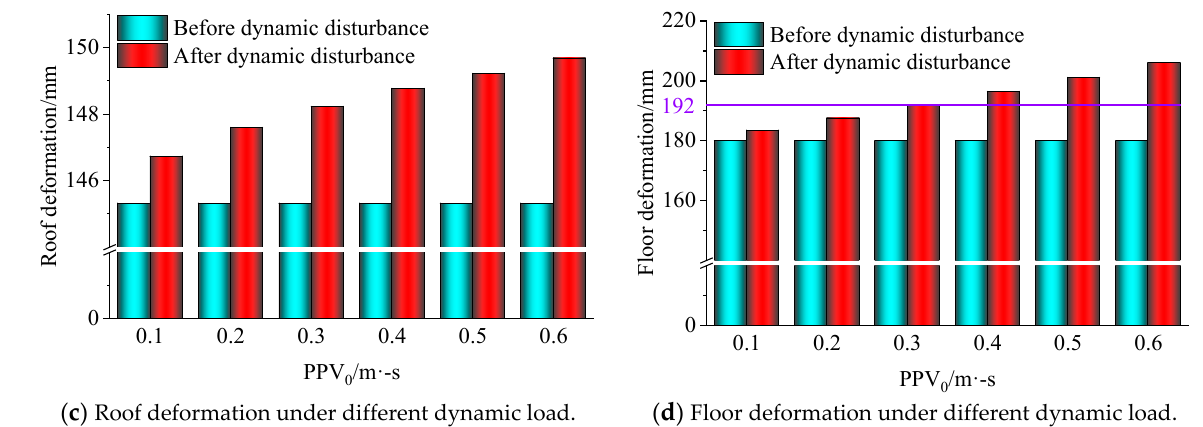
Figure 14. Roadway deformation with respect to different PPVs.